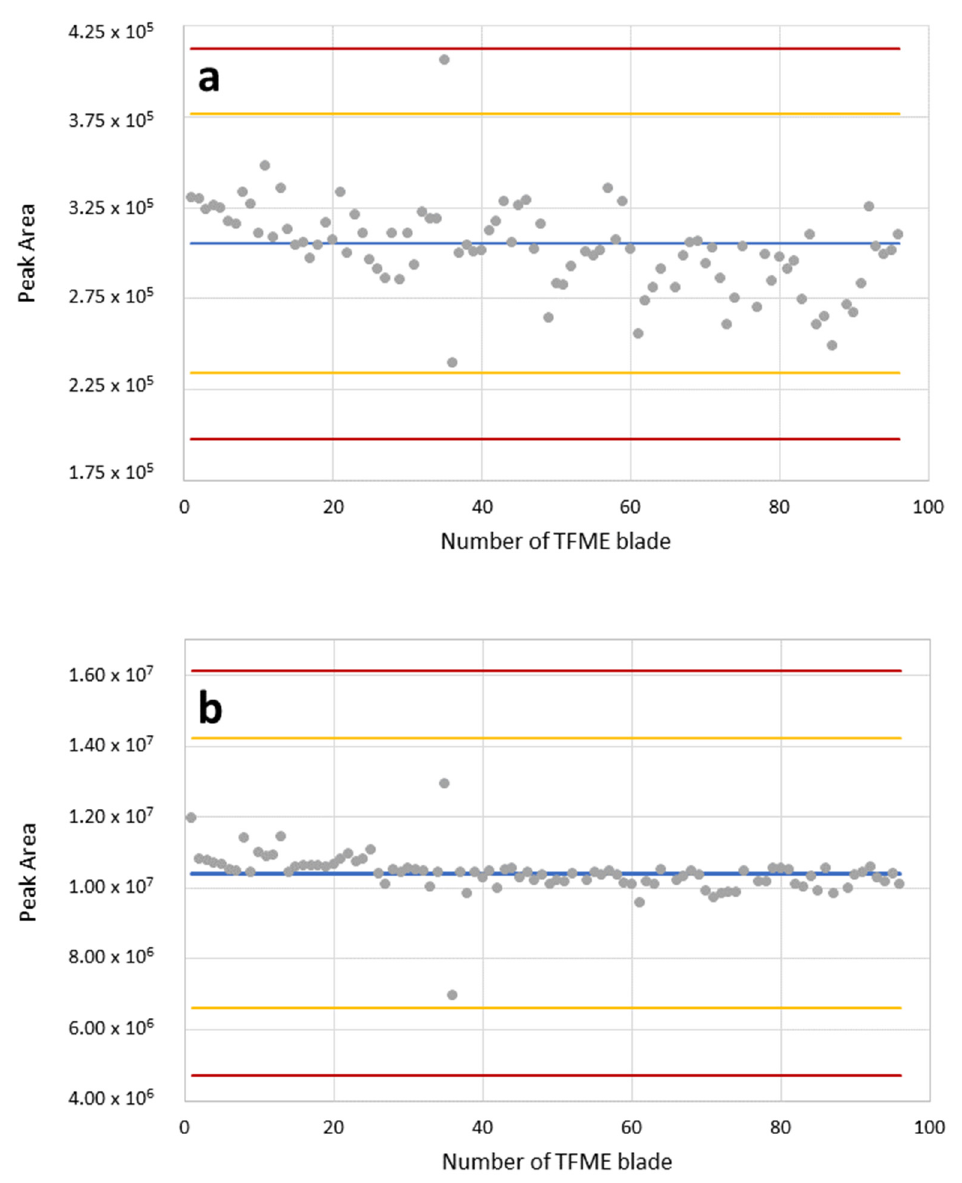
Figure 1. Shewhart charts for QC of self-made TFME blades coated with DVB for imipenem ( a ) and piperacillin ( b ) extraction at concentration 0.1 mg/L. Determined peak areas for all blades are given as grey points. Red lines denote control limit ( ± 3 σ ), yellow lines denote warning limits ( ± 2 σ ) and the blue line indicates mean peak area for all blades.